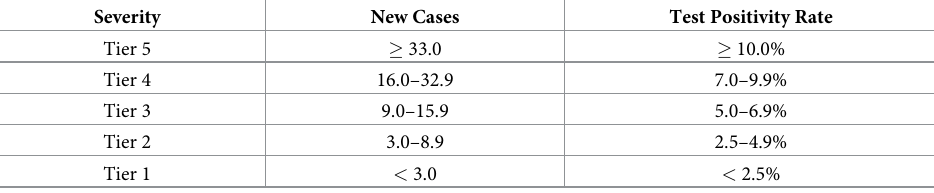
Table 1. Severity categorization scheme defined by the quintiles of the training